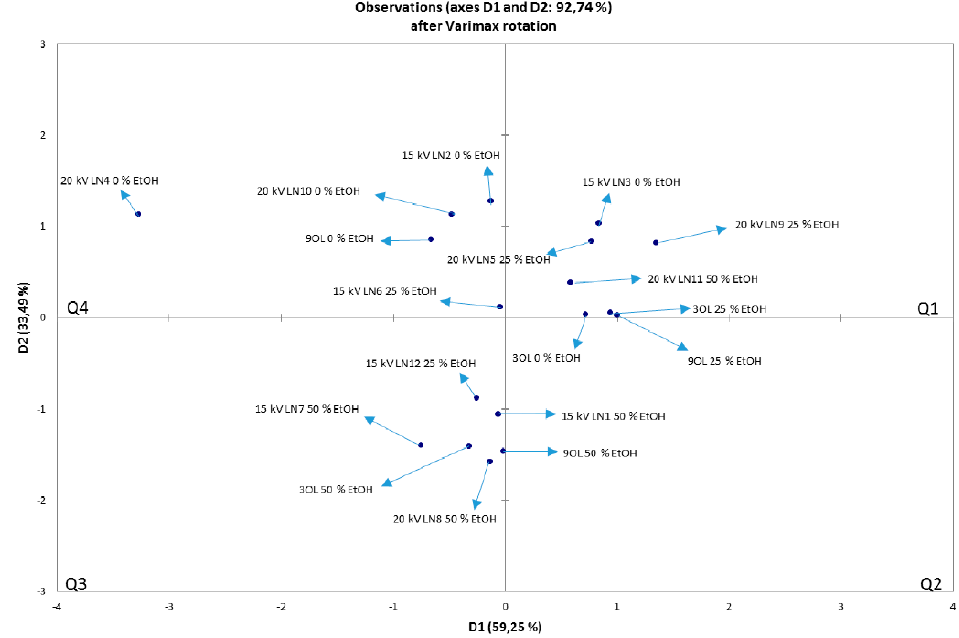
Figure 8. The PCA of untreated and HVED treated samples. The data is denoting untreated OLEs (CE), and OLEs treated with HVED using nitrogen. Q stands for quadrant.